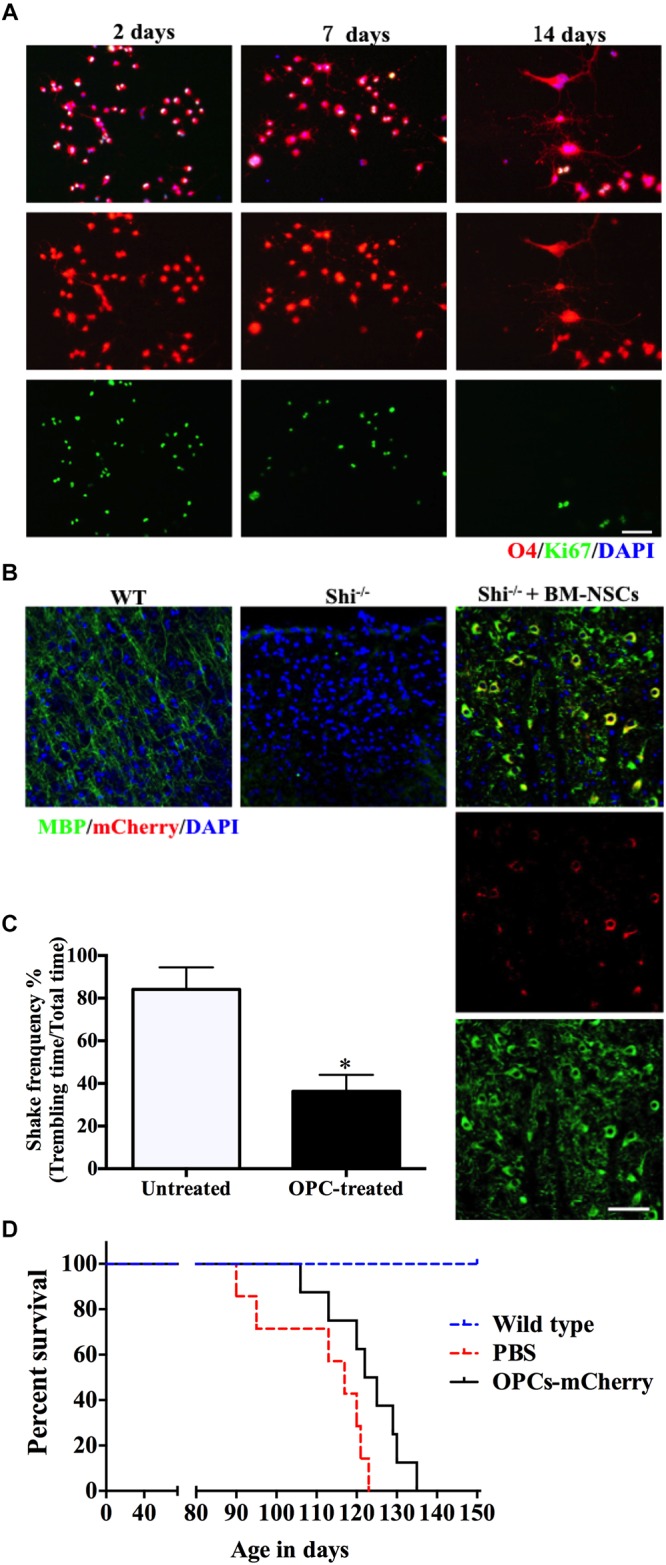
BM-NSCs OLGs differentiation in vitro and transplantation in Shi mice. (A) BM-NSCs were cultured in oligodendrocyte differentiation media for 48 h, 1 week, and 2 weeks for O4 (differentiation marker) and Ki-67 (proliferation marker) staining. (B) Fluorescence staining of BM-NSCs (mCherry+ cells), after 35 days post injection, show myelination (MBP+) in the contralateral striatum. Scale bar = 50 μm. (C) Quantification of tremor of Shi mice treated with OPCs. (D) Transplanted OPCs prolong the survival of Shi mice compared with PBS-treated (n = 9). Symbols represent mean ± SD. ∗p < 0.05, Student’s t-test.